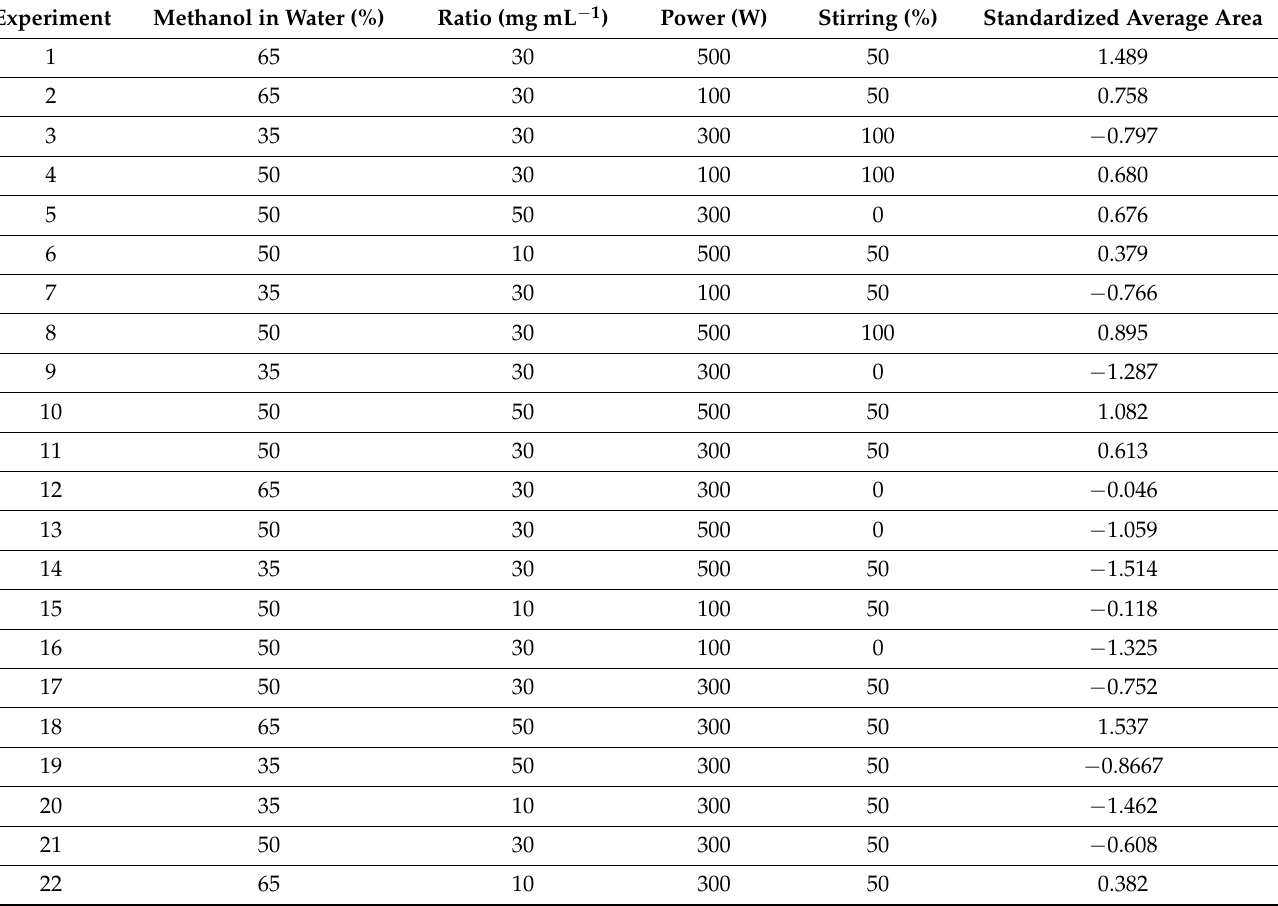
Table 1. Conditions used and results for the extractions in the experimental